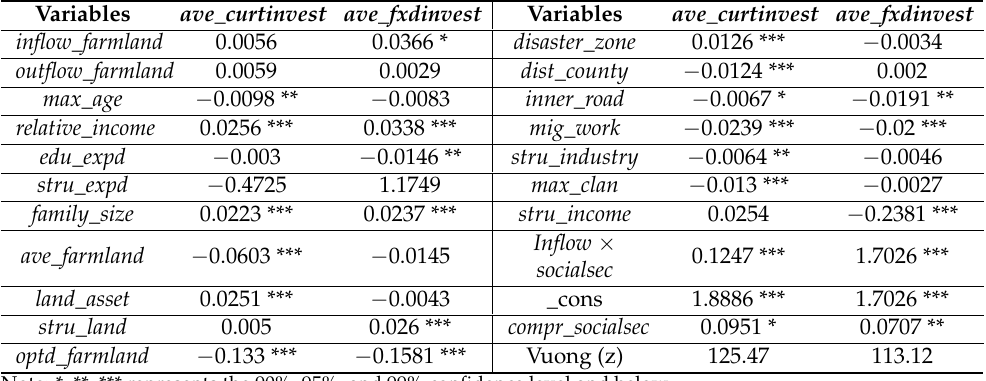
Table 3. The zero-inflated Poisson regression